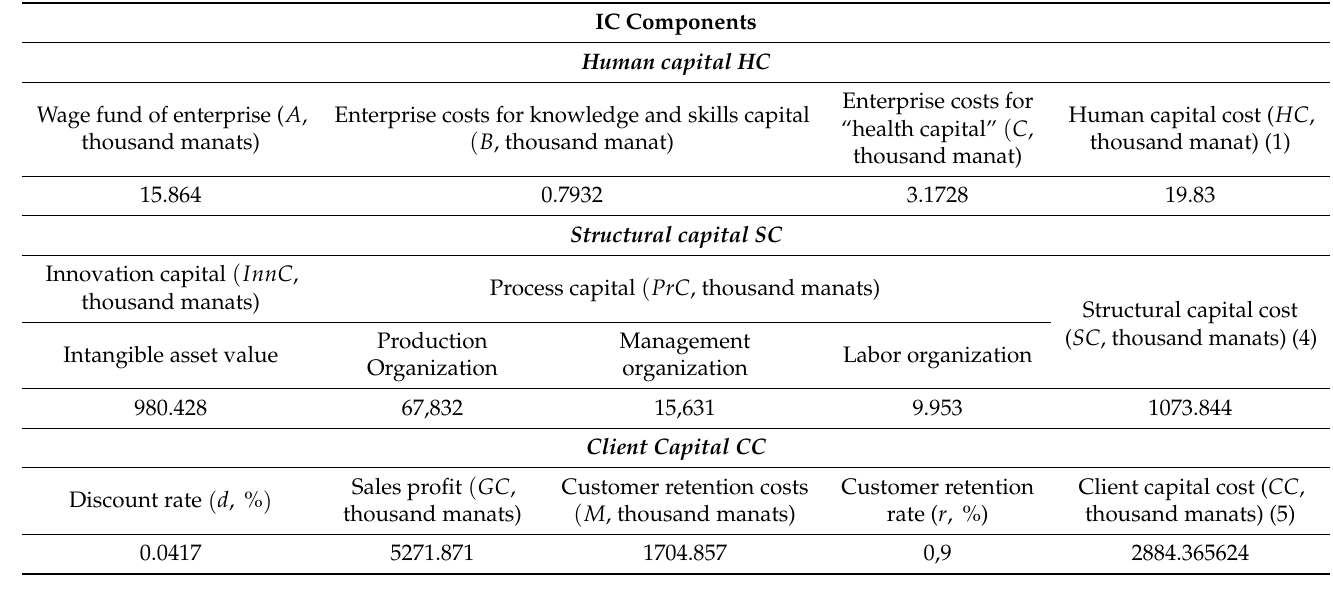
Table 2. Assessment of IC